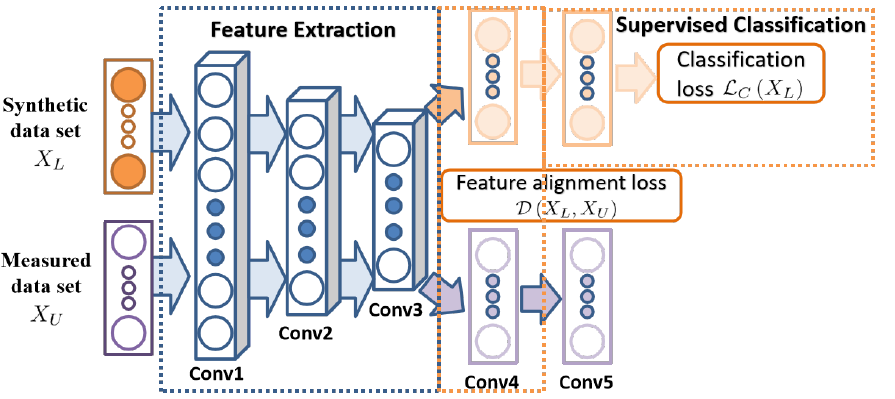
Figure 4. Feature alignment classification